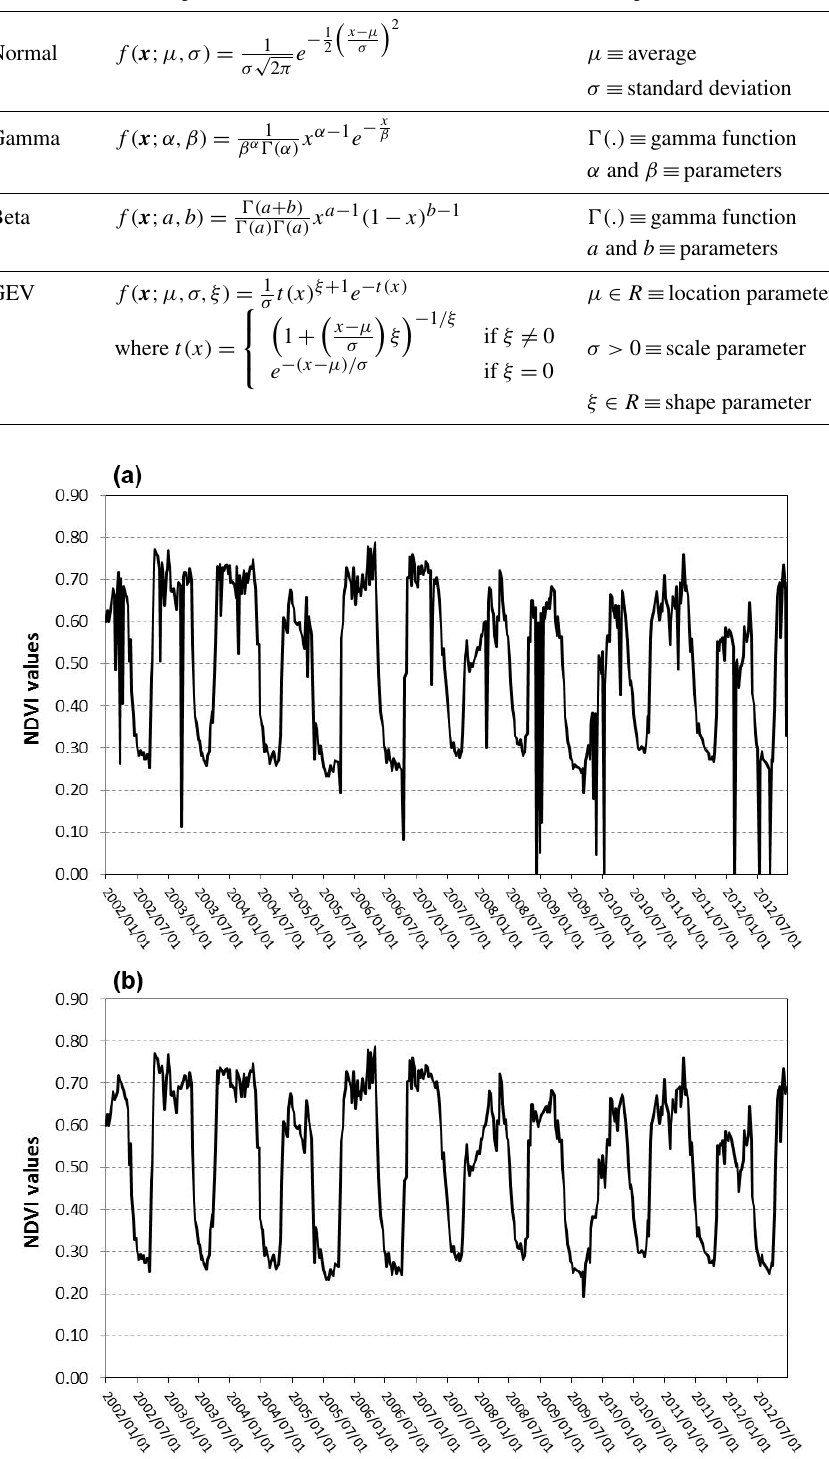
Figure 3. HSL filtering criterion applied to a 10-year NDVI series. (a) shows the real NDVI series. (b) shows the HSL-filtered NDVI